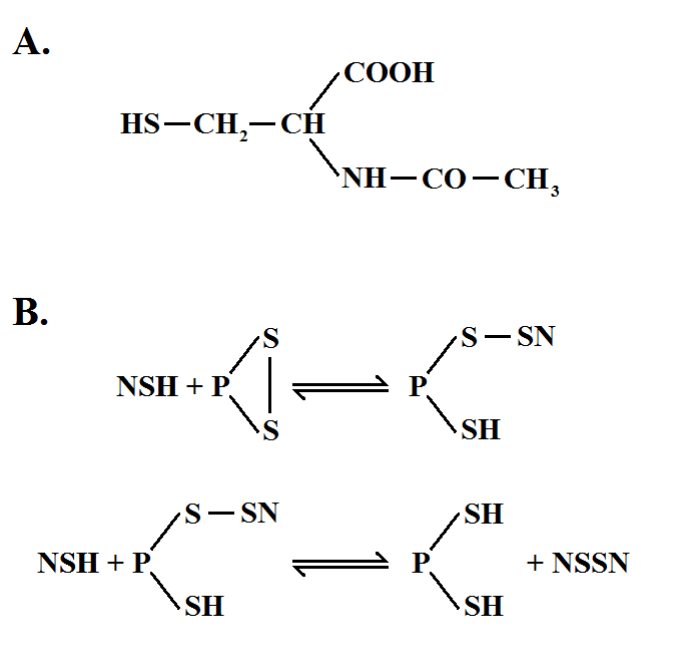
Figure 1. Structural formula of N-acetylcysteine (NAC; A ). Disulfide bonds in proteins (P) can be disrupted by NAC in a two-step thiol-disulfide interchange reaction ( B ). Adapted from Samuni et al